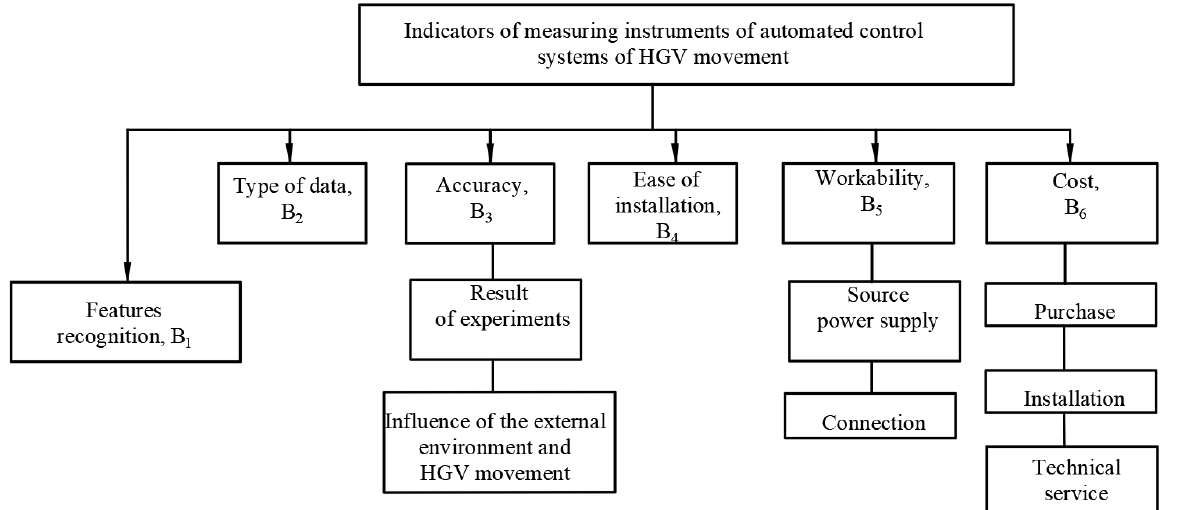
Figure 5. Indicators of means of measurement of the telematic automated system for the weight control system of HGVs (TASWC HGV).